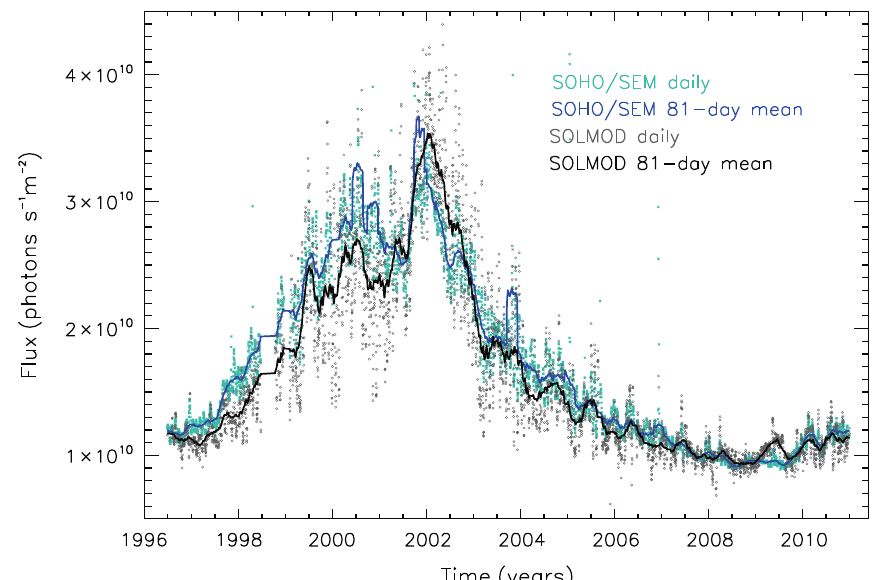
Fig. 8. Comparison of the SOLMOD reconstruction (gray) with the SOHO/SEM (light blue) irradiance data. The 81-day mean is also given for the reconstruction (black line) and the SOHO/SEM data (dark blue line). The data gaps in the SEM data as well as in the reconstruction are during the SOHO vacation in summer and fall of